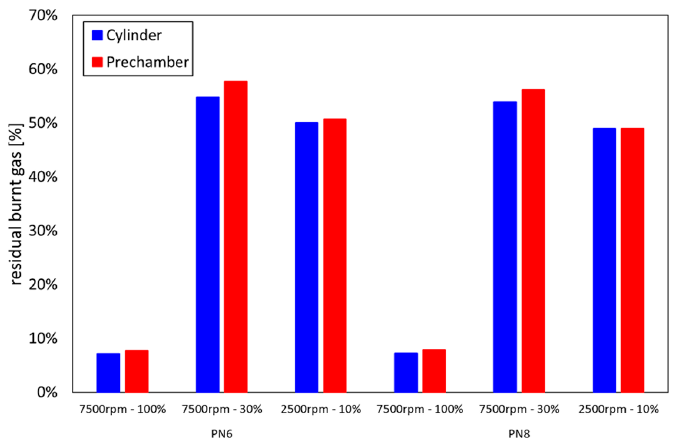
Figure 14. MFBG inside cylinder and prechamber for PN6 and PN8 systems at 360 °CA.